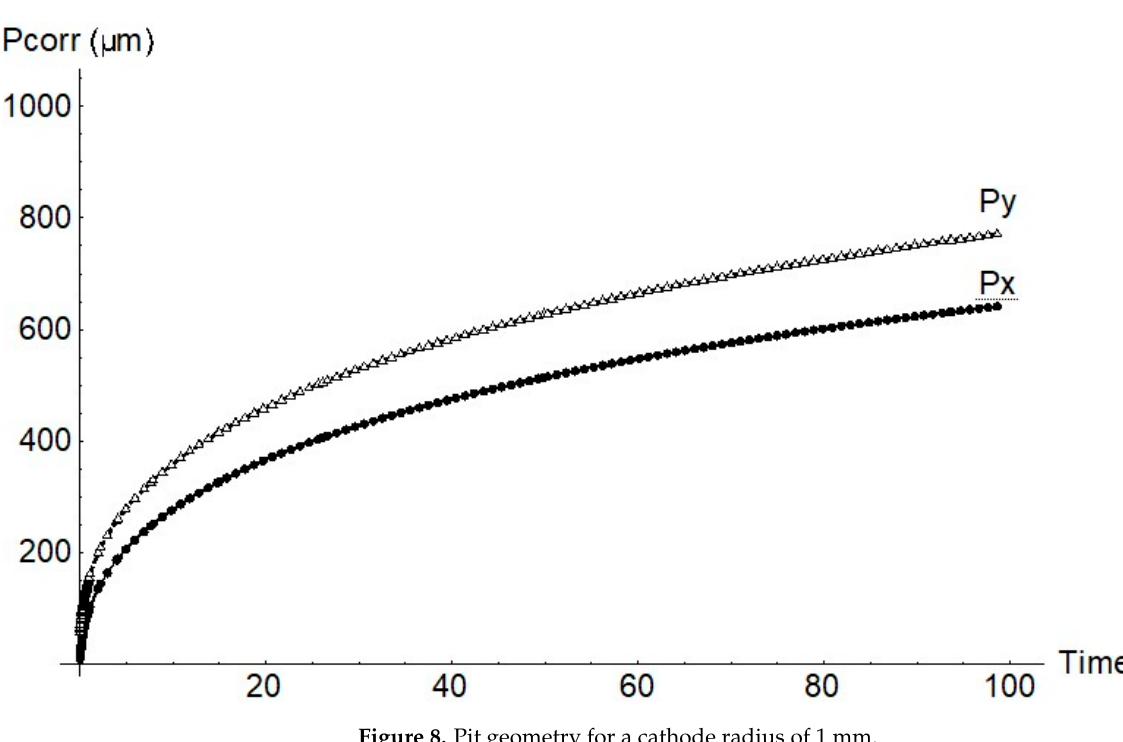
Figure 8. Pit geometry for a cathode radius of 1 mm.